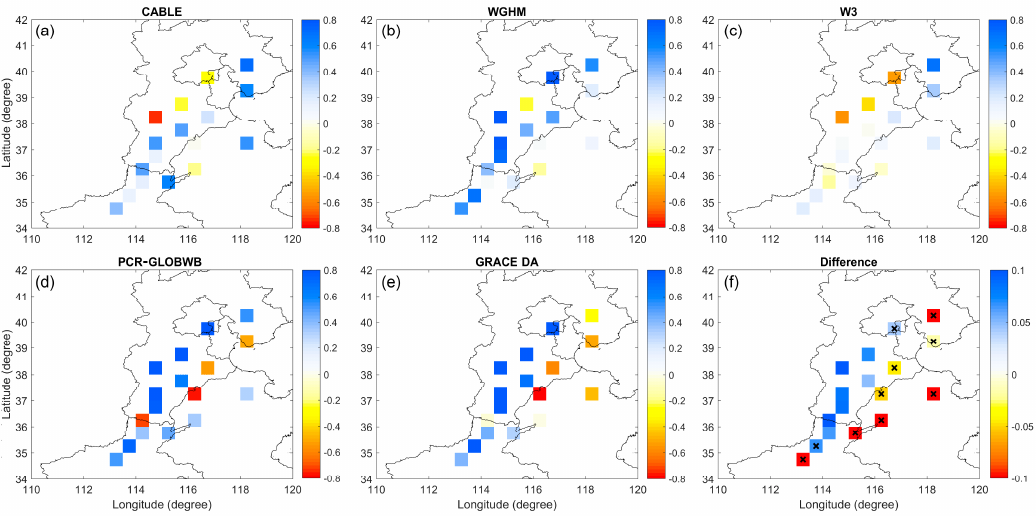
Figure 10. Same as Figure 9 but in NCP. The cross (x) mark in ( f ) indicates the groundwater measurement associated with shallow aquifer (averaged depth less than 10 m).